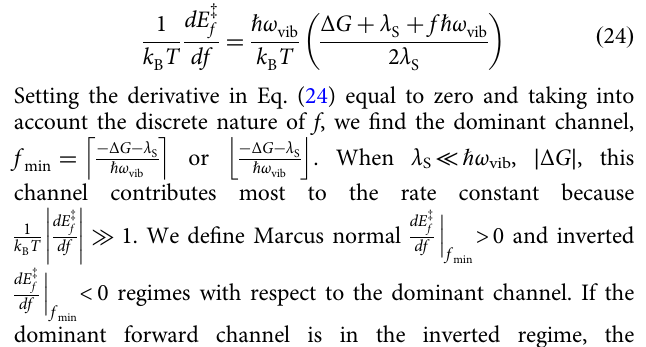
dominant forward channel is in the inverted regime,